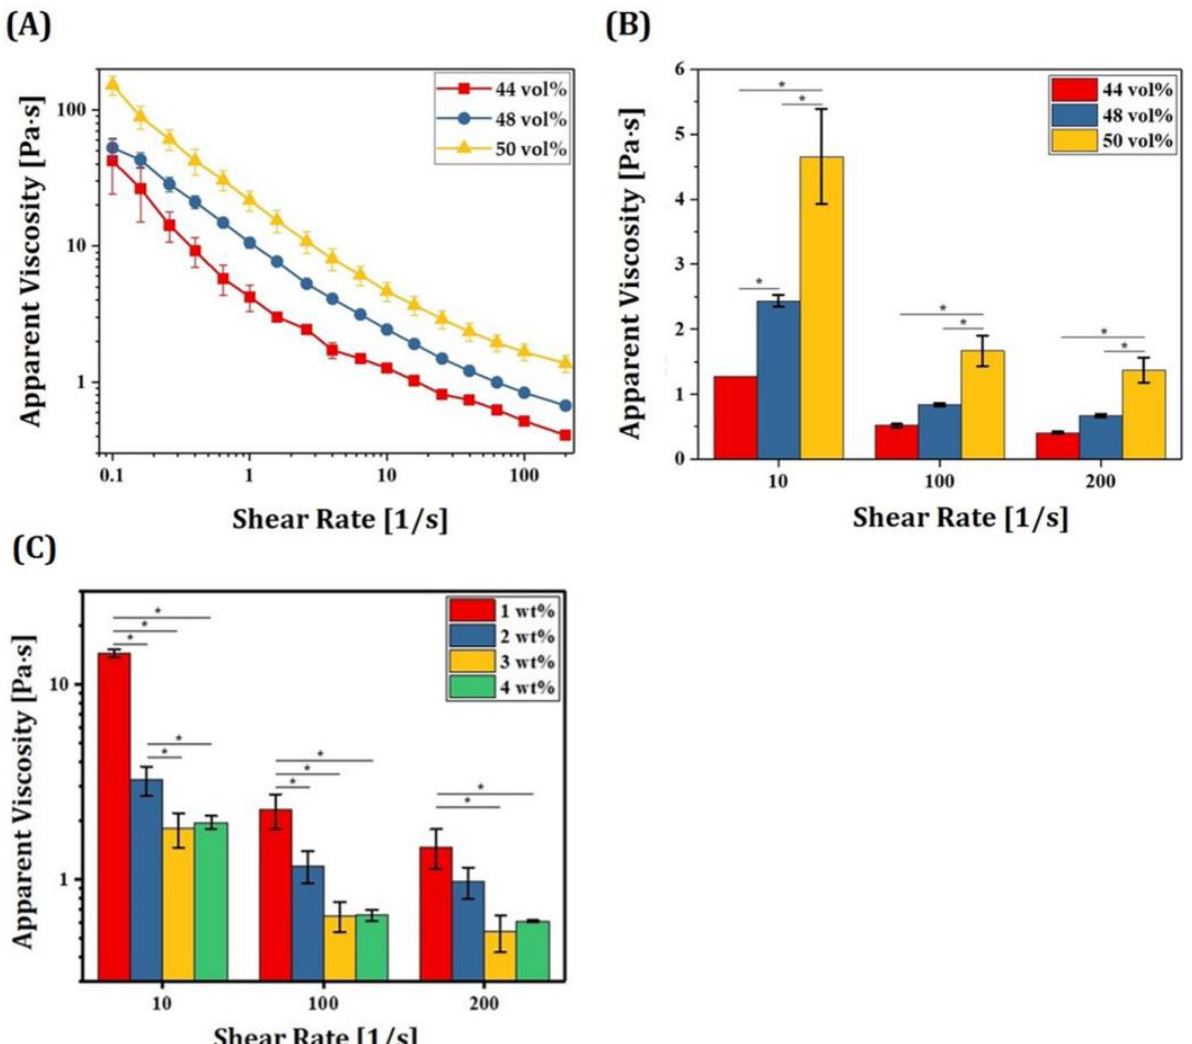
Figure 8. ( A ) Apparent viscosities as a function of shear rate observed for 5Y-PSZ suspensions prepared using a range of solid loadings (44 vol%, 48 vol% and 50 vol%), ( B ) apparent viscosities at various shear rates observed for 5Y-PSZ suspensions (* p < 0.05), and ( C ) apparent viscosities of 5Y- PSZ suspensions with a solid loading of 50 vol% prepared using a range of dispersant contents (* p < 0.05).